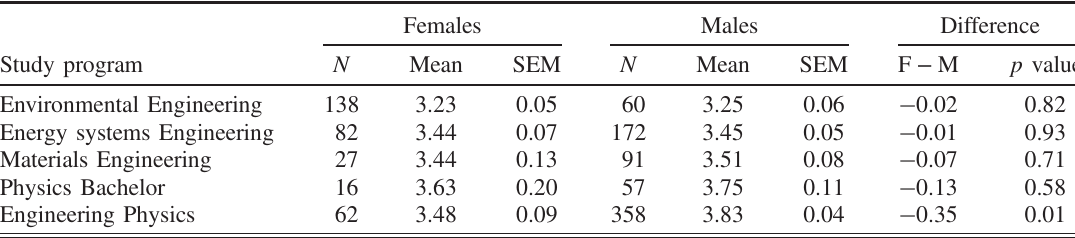
TABLE IV. Comparison of course grades for female and male students passing the electromagnetism course on the five largest study